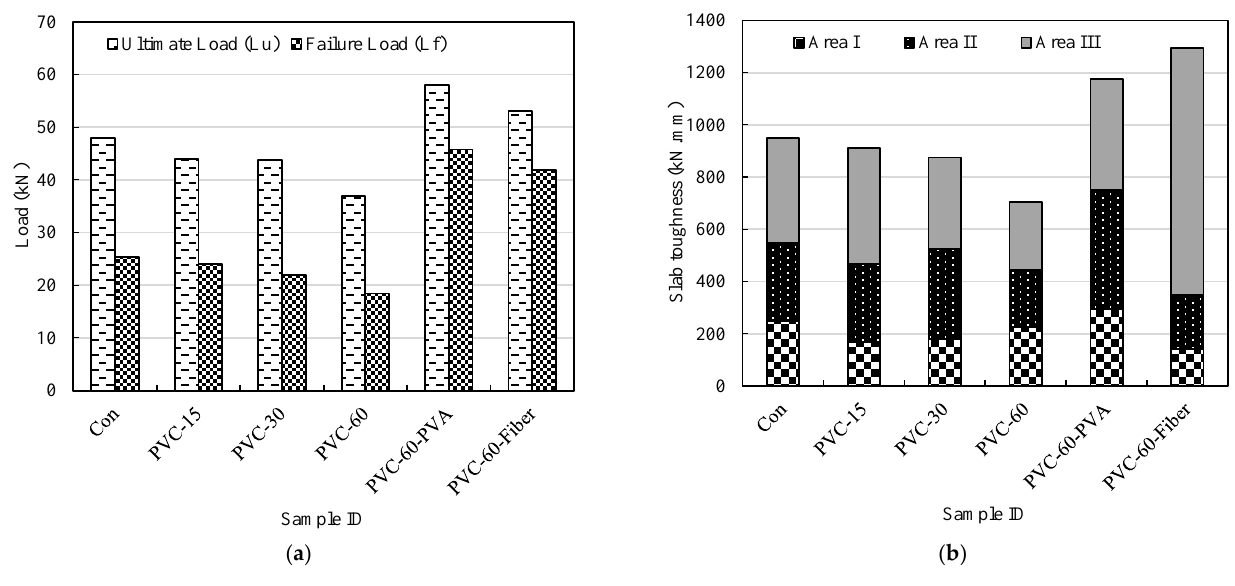
Figure 9. ( a ) Ultimate and failure loads and ( b ) slab toughness.